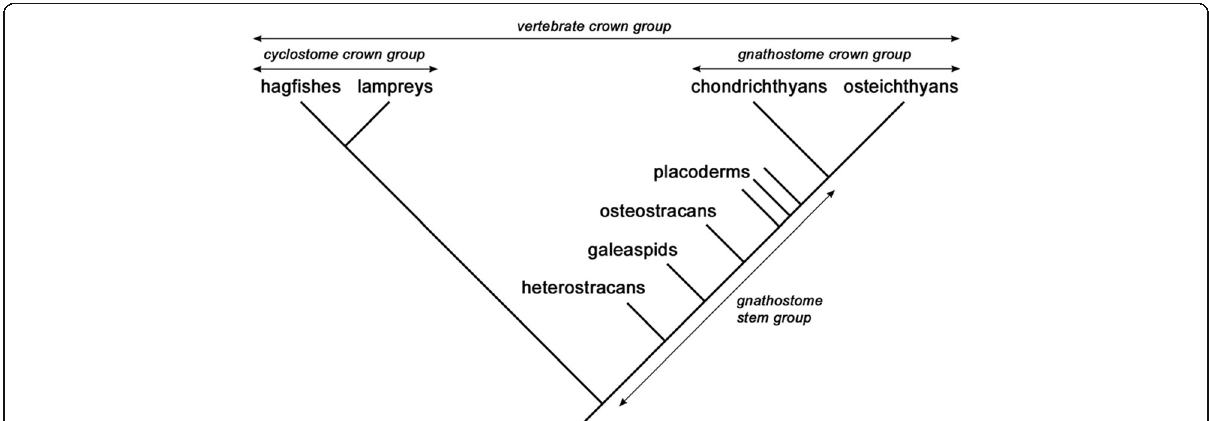
Fig. 4 Phylogeny showing the fossil groups discussed in this paper and their relationship to extant gnathostomes and cyclostomes. Double-headed arrows indicate the extent of groups. A stem group contains only fossil taxa; a crown group is defined on the basis of living taxa, but can also include fossils. Heterostracans, galeaspids, osteostracans and placoderms are thus stem gnathostomes but crown